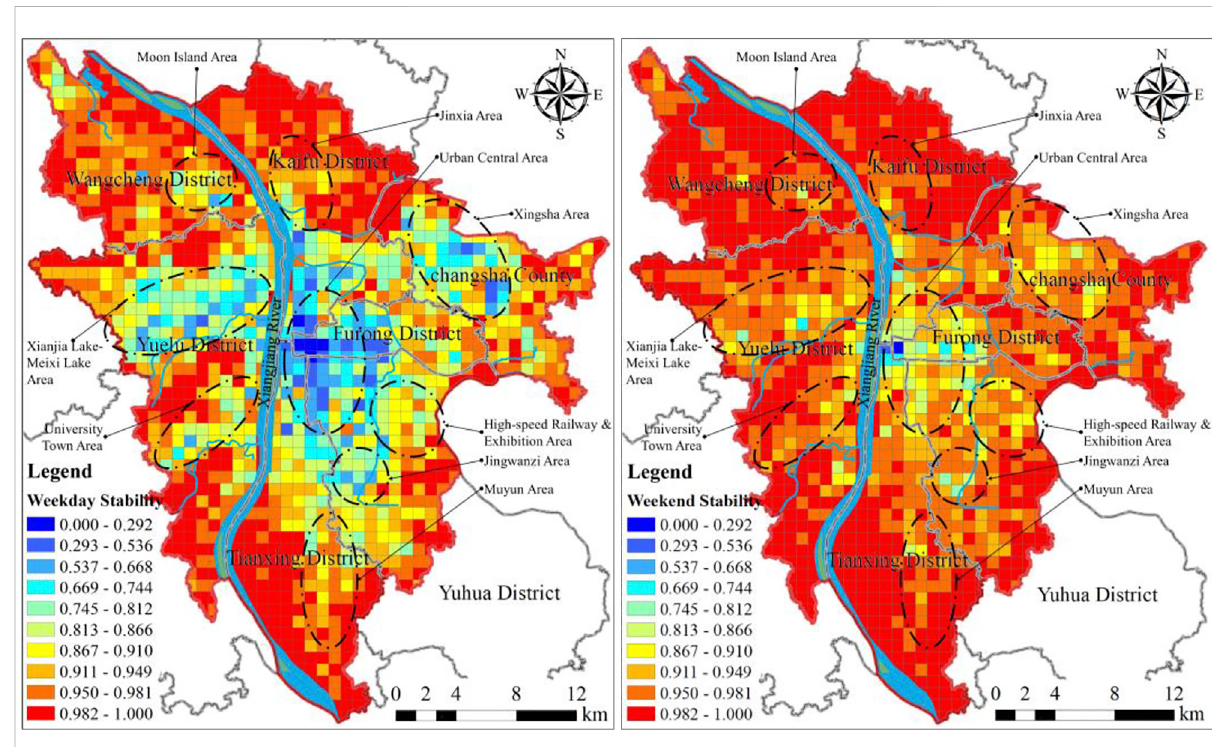
FIGURE 5 Weekday (left) and weekend (right) stability of human